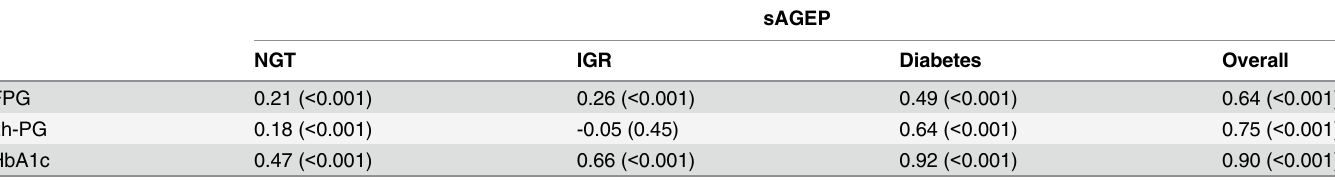
Table 3. Age-adjusted partial correlations between sAGEP and FPG, 2h-PG, and HbA1c.